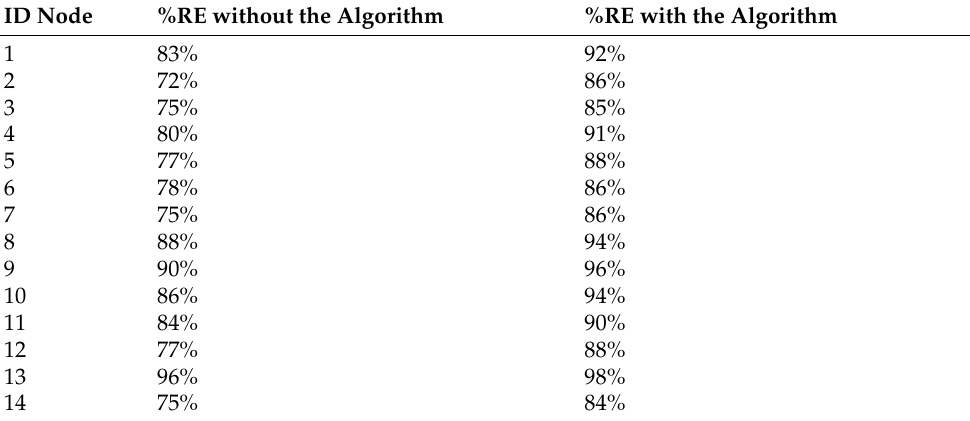
Table 6. Remaining energy (RE) in each sensor with and without the application of algorithm. ID Node %RE without the Algorithm